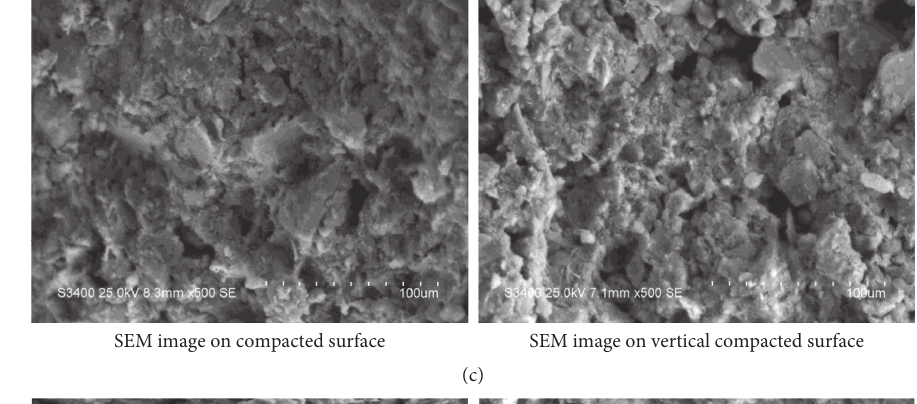
� 1.70 g/cm 3 , (b) ρ � 1.60 g/cm 3 , (c) ρ � 1.50 g/cm 3 , and d d d